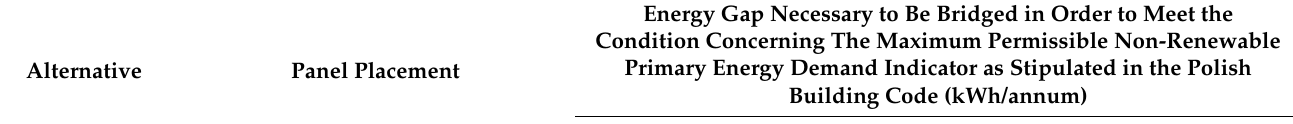
Table 8. Calculation results for energy gap to be bridged in order to meet the nZEB requirements, monthly balance